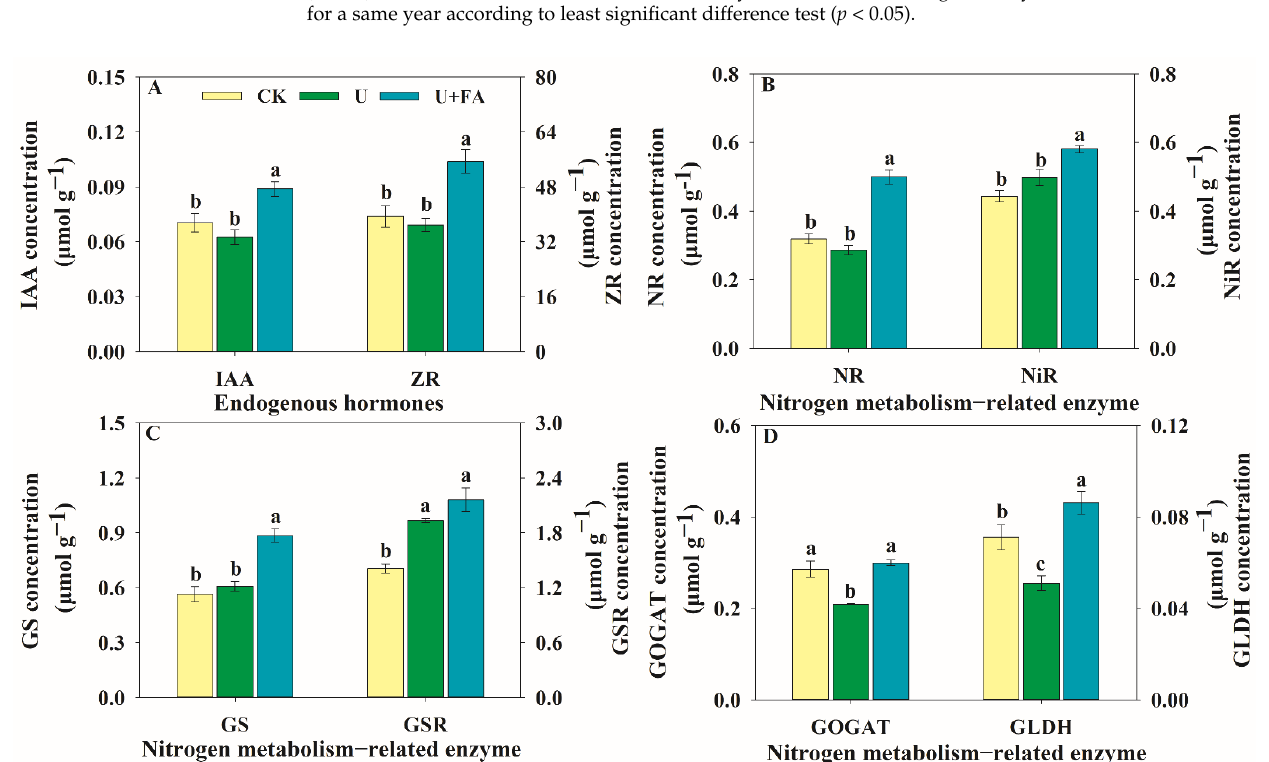
Table 4. Effects of different fertilization treatments on plant height and stem diameter at the differ- ent growth stages of maize, in 2017.